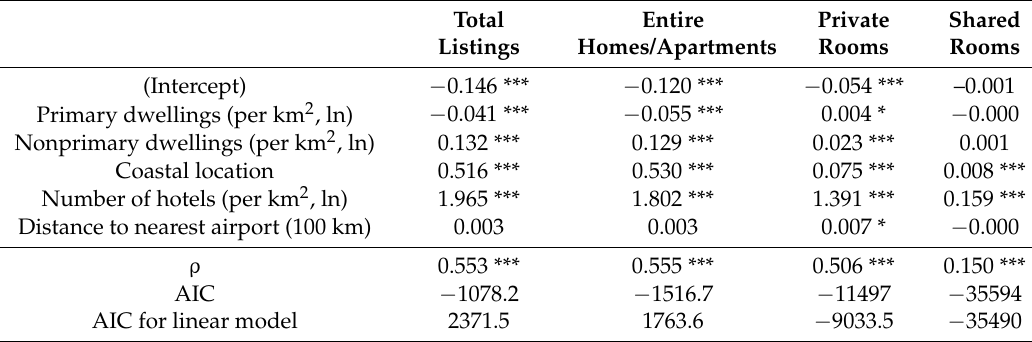
Table A7. Initial spatial lag models for municipalities (N = 8117).